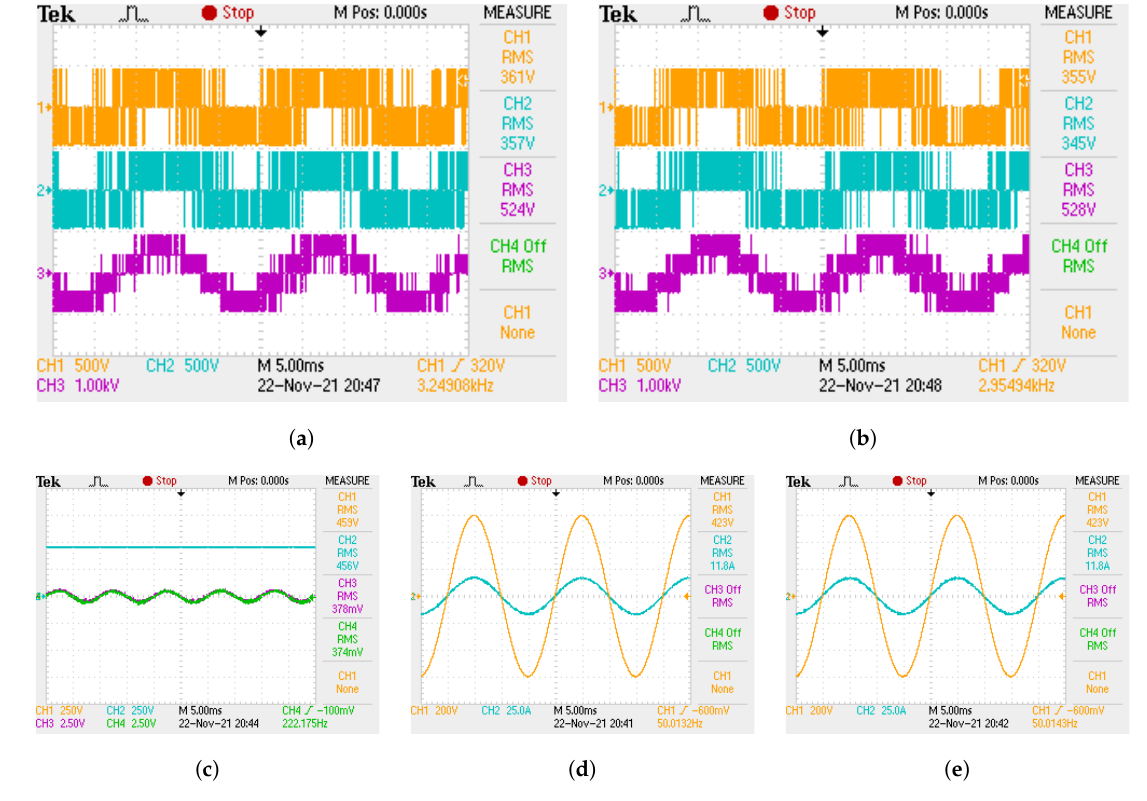
Figure 20. The 2-modules ISOS configuration experimental results: ( a ) primary side switching voltages, ( b ) secondary side switching voltages, ( c ) DC-links voltages, ( d ) primary side grid voltage and current, ( e ) secondary side grid voltage and